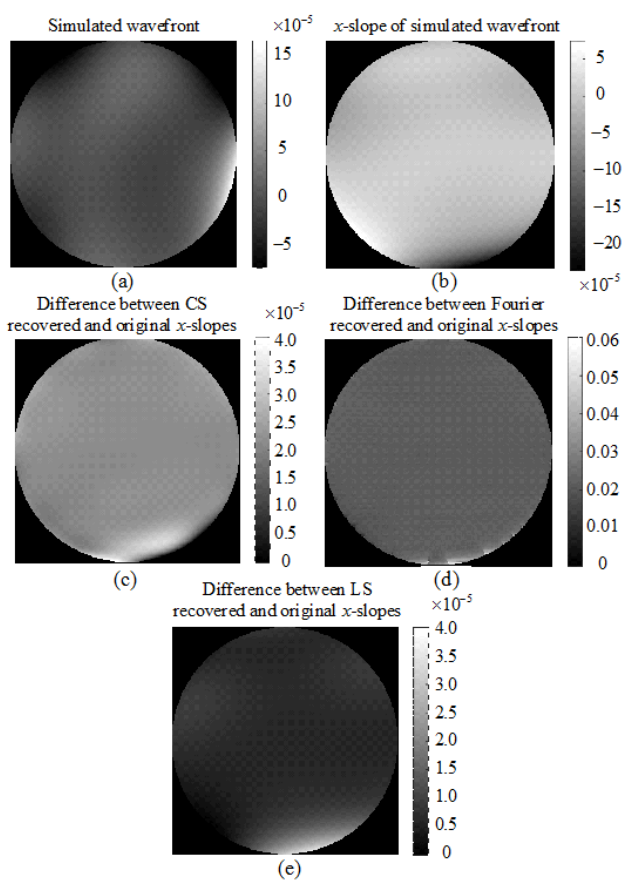
Fig. 5 Comparison of simulated slope reconstructions: (a) the simulated wavefront and its (b) phase slope in the x direction, (c) error map using compressed wavefront sensing, (d) error map using Fourier demodulation, and (e) error map using iterative modal wavefront reconstruction.